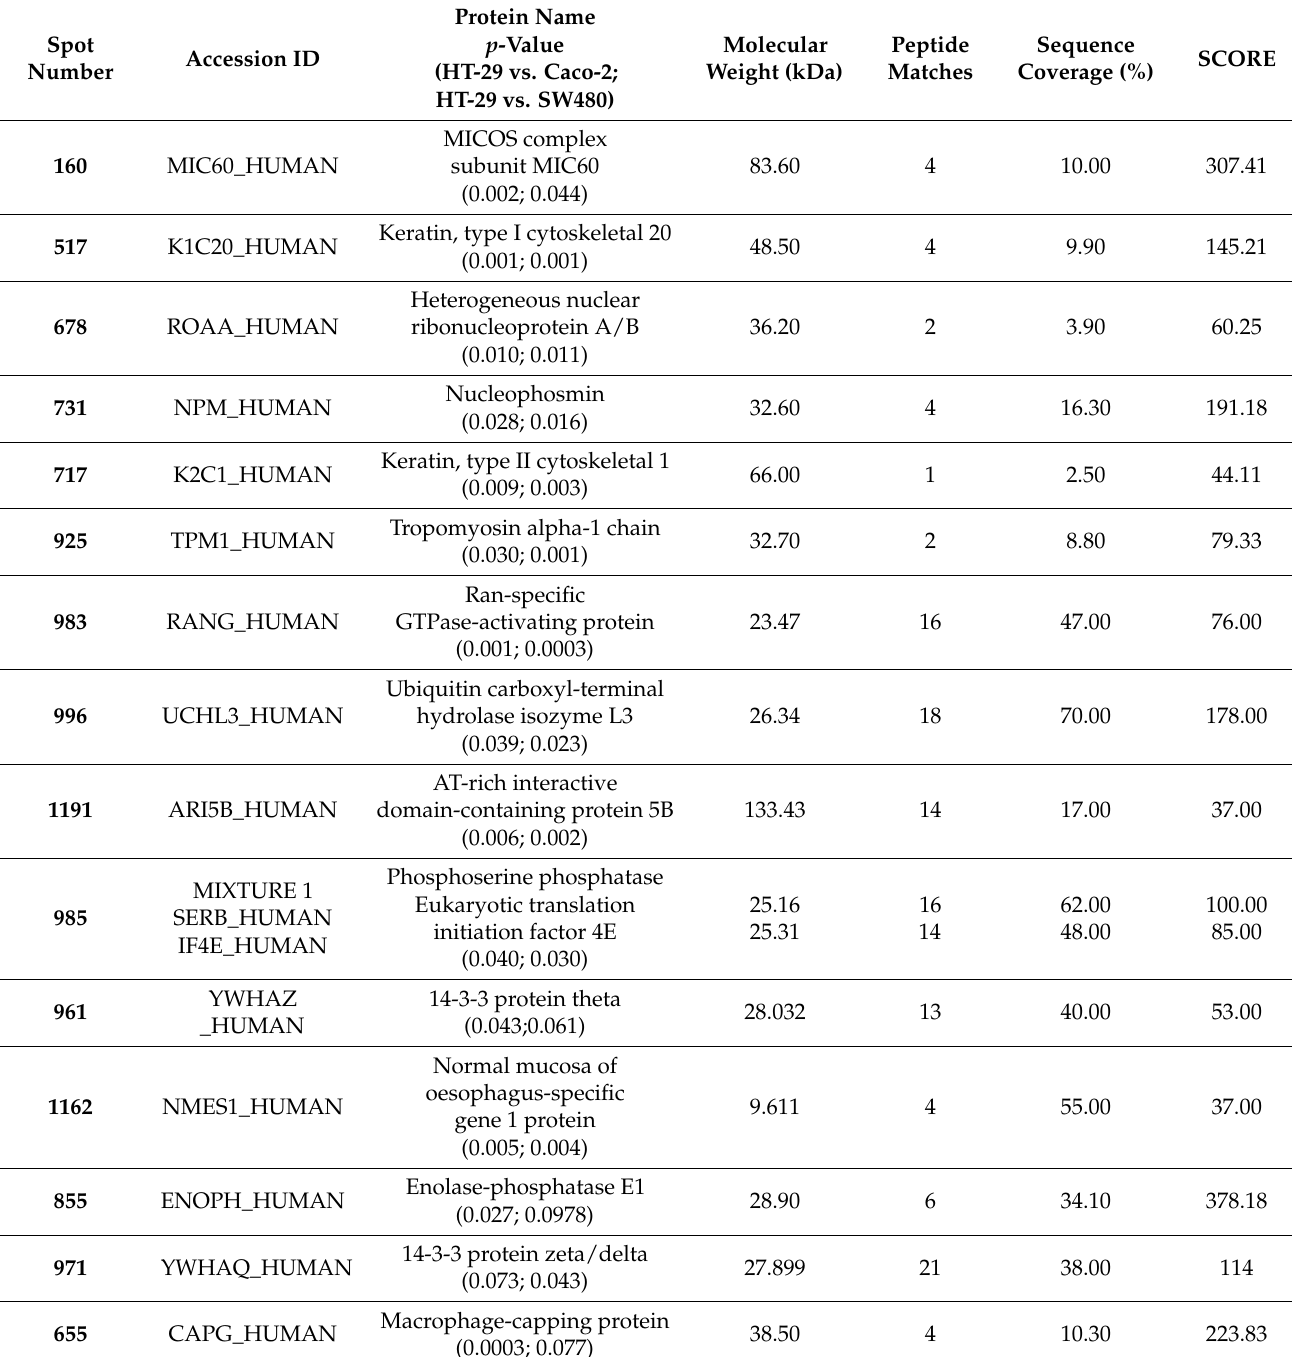
Table 1. List of differentially up-regulated proteins with statistical significance ( p < 0.05) in BRAFV600E mutant HT-29 cells in comparison to Caco-2 and SW480 colon cancer